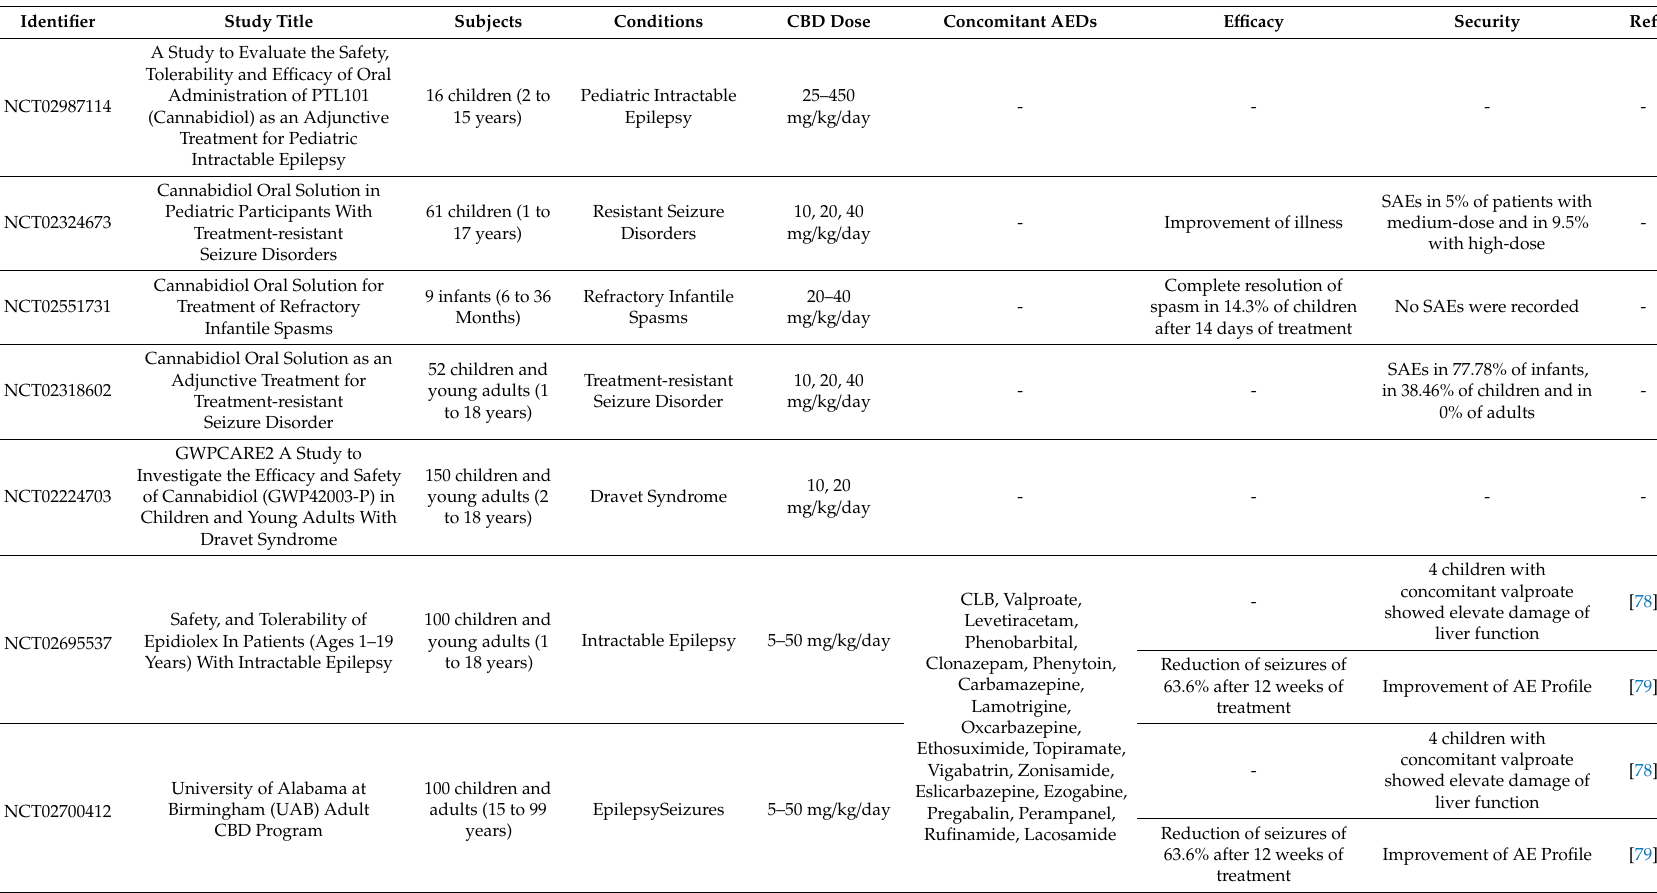
Table 1. Completed cannabidiol clinical trials in epilepsy (https: // clinicaltrials.gov / ). The table shows the e ffi cacy and safety of CBD in di ff erent forms of epilepsy. In all studies, CBD is used as adjunctive therapy to conventional antiepileptic